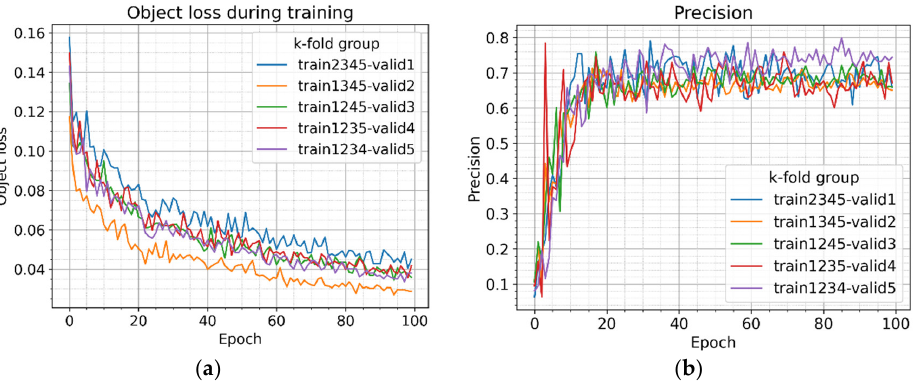
Figure 7. Object loss ( a ) and precision ( b ) for validation datasets during training epochs in K-fold cross-validation.